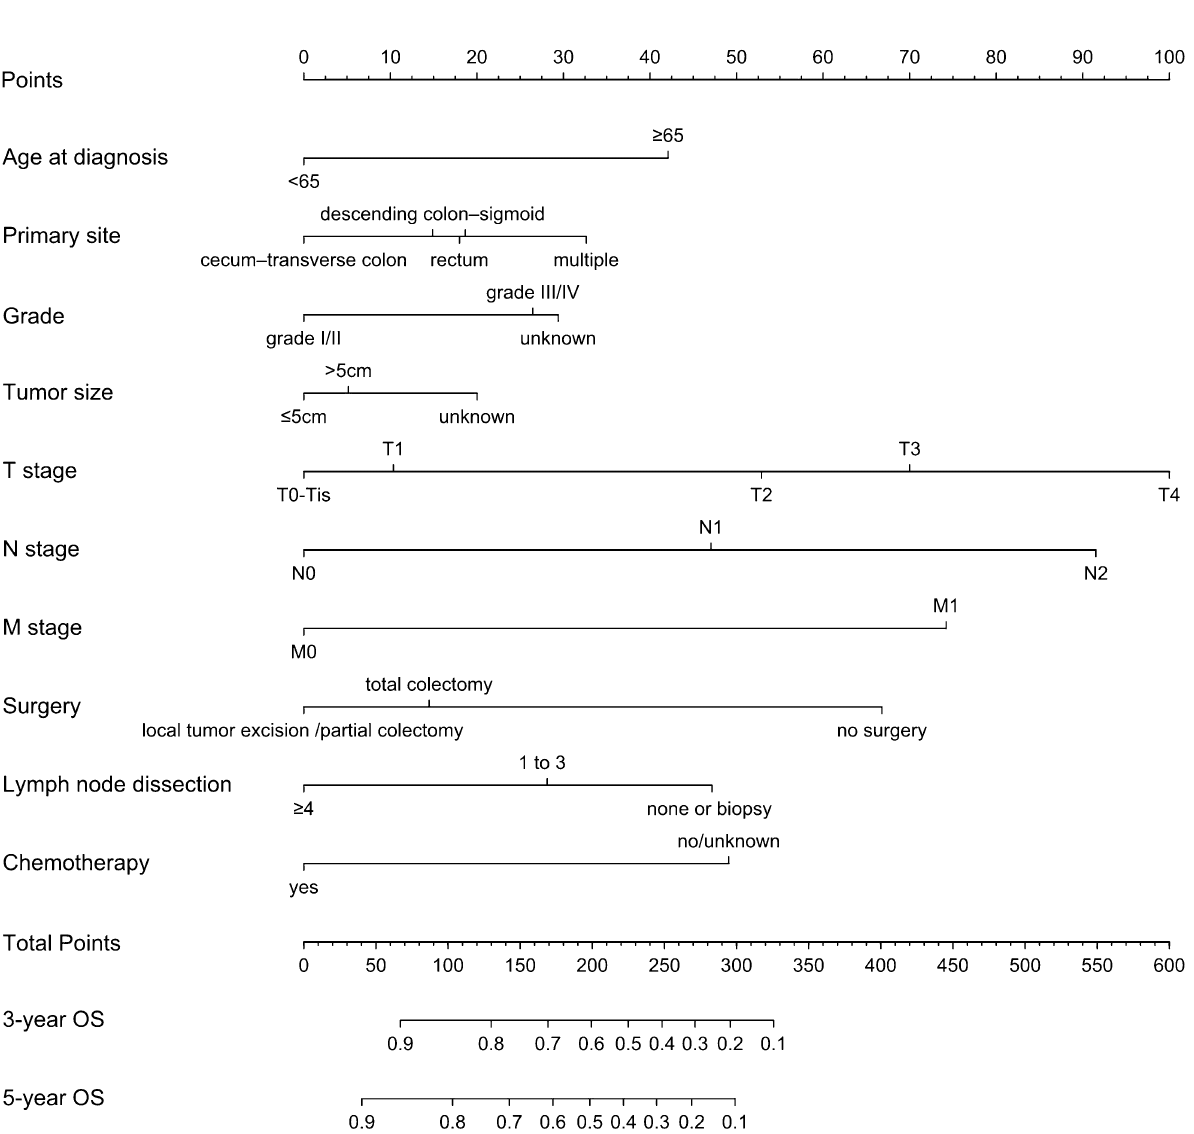
Figure 2. Nomogram to predict 3-year ( A ) and 5-year ( B ) overall survival (OS) of colorectal SRCC